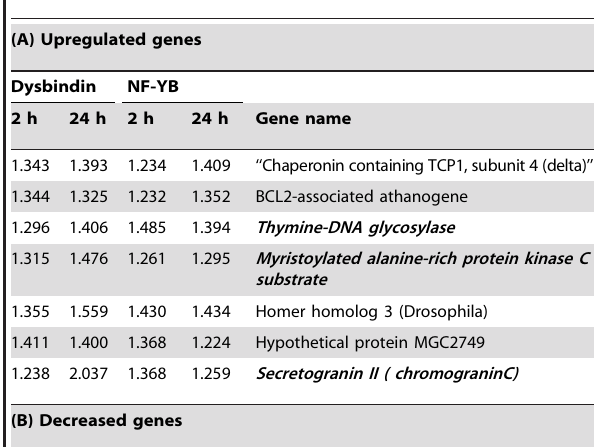
Table 1. The list of genes altered by Dysbindin as well as NF- YB.